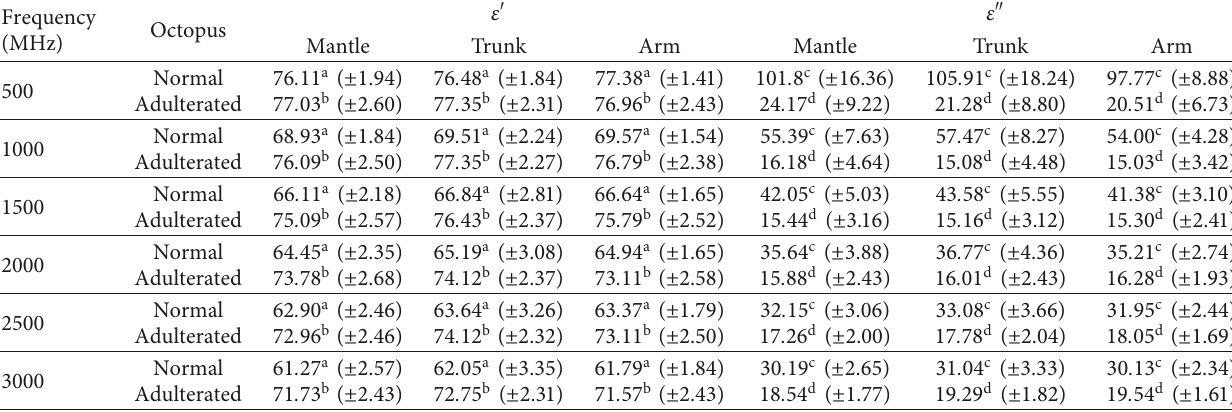
Table 1: Dielectric properties of normal and adulterated Octopus minor at different parts and frequencies.